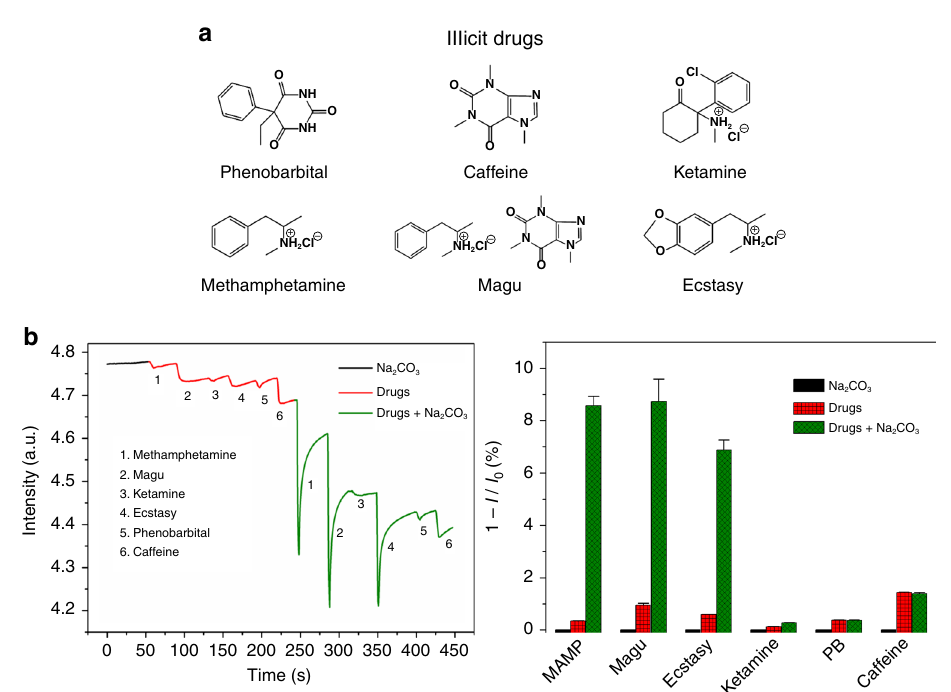
Fig. 7 Illicit drug detection under different condition. a The chemical structures of the drugs. b Fluorescence responses of fi lm 1 to the drug vapors in the presence or absence of Na 2 CO 3 . c Comparison of relevant responses. Clearly, introduction of the base enhances the response of the fi lm to the drugs, especially to MAPA, magu, and ecstasy, of which the measurements were conducted for fi ve times and the error bars are drawn from the maximum responses